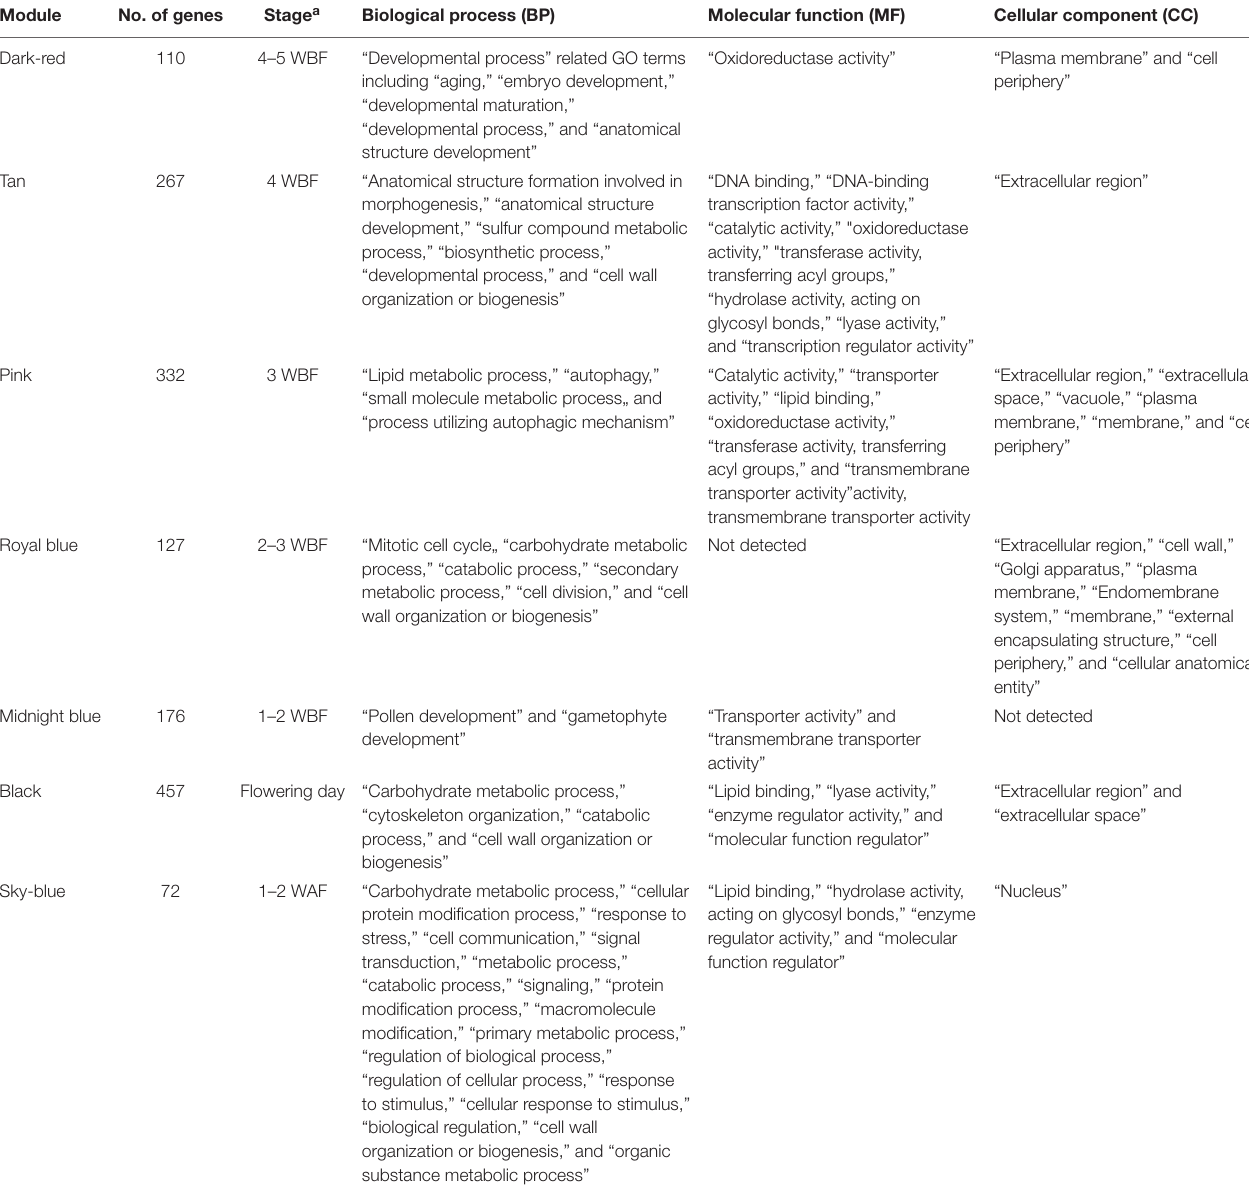
TABLE 1 | Gene Ontology (GO) terms enriched at the different flowering